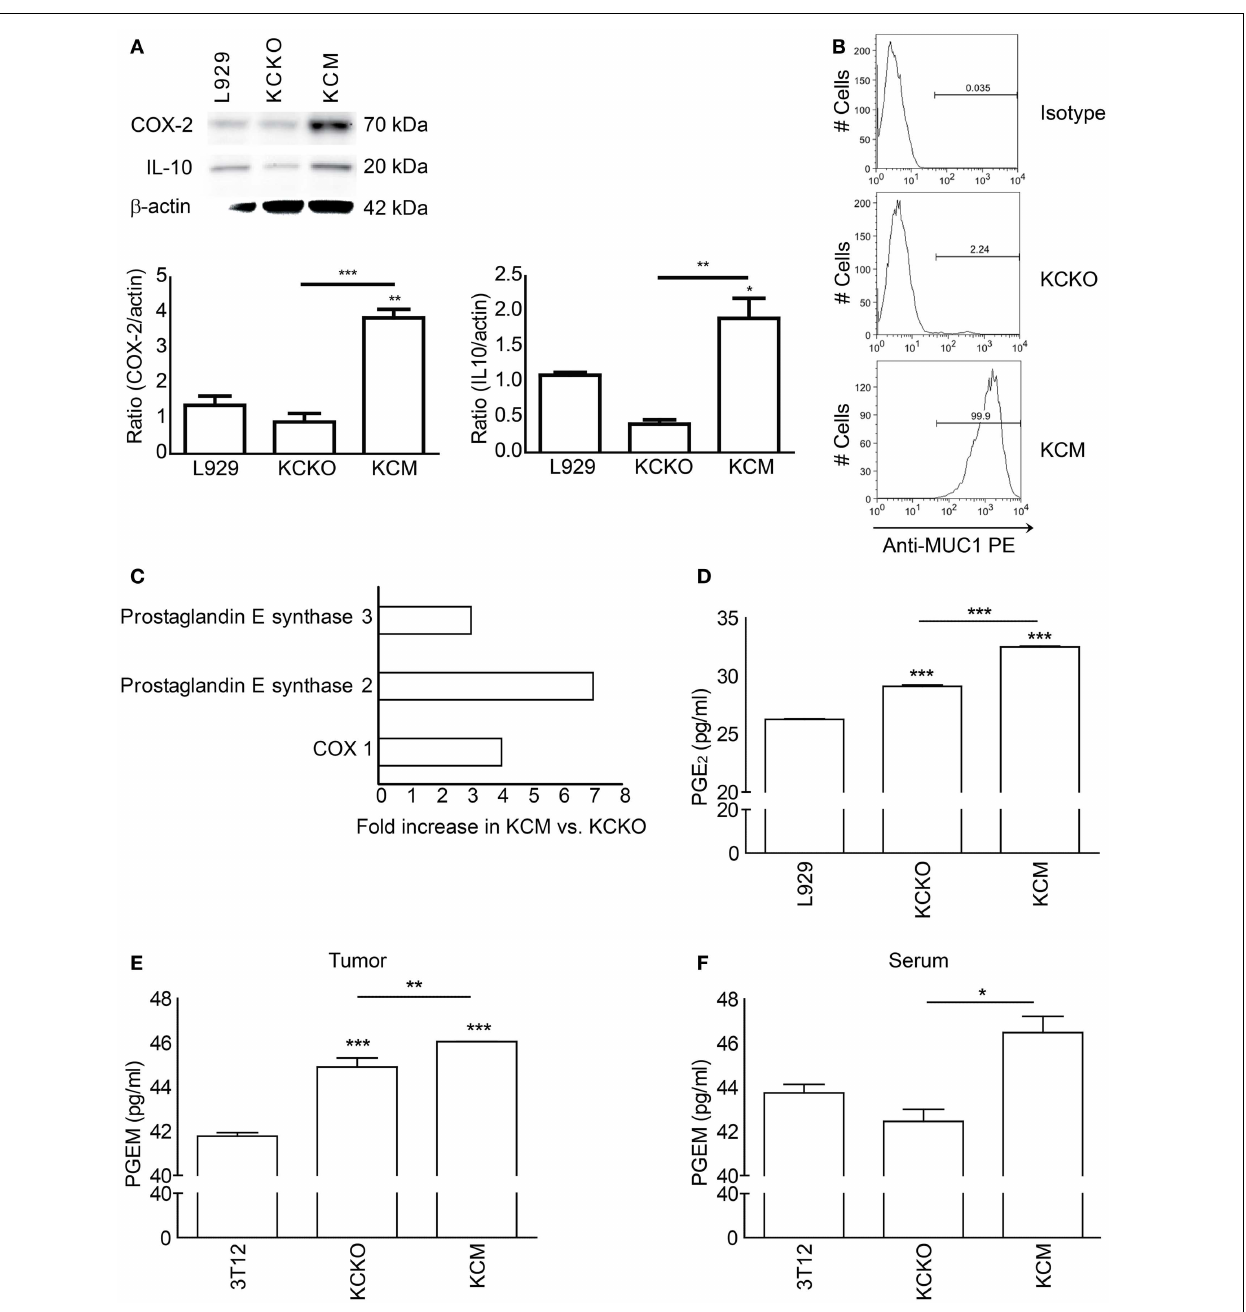
MUC1 cells was set using the appropriate isotype control; (C) Proteins over-expressed in KCM versus KCKO-tumor cell lysates from tumor-bearing mice determined by proteomics analyses (Data expressed in fold changes); (D) PGE 2 concentrations in conditioned media of KCM and KCKO cells measured by ELISA; (E,F) PGEM (13,14-dihydro-15-keto PGA 2 ) concentrations quantified by ELISA in serum and tumor lysate from tumor-bearing mice ( n = 4). Mean and standard error plotted. * p < 0.05, ** p < 0.01, and *** p < 0.001 for statistically significant differences from control levels unless indicated by the line above the